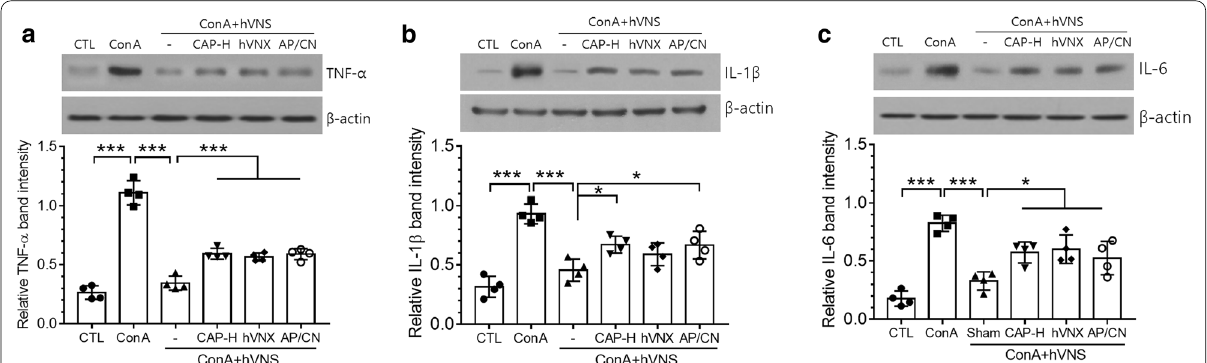
Fig. 8 Regulation on the production of inflammatory cytokines by CAP in ConA‑injected animals. Levels of inflammatory cytokines TNF‑α ( a ), IL‑1β ( b ), and IL‑6 ( c ) in the liver tissue were analyzed by western blot analysis. All of western blot images in a – c are the representatives from 4 independent experiments, and quantification of protein bands relative to actin protein was plotted (lower panels). Western blotting for actin as internal loading control. AP/CN; a group injected with AP‑5/CNQX into the DMV. In a – c , one way ANOVA with Tukey post hoc is shown. *p < 0.05, ***p < 0.001